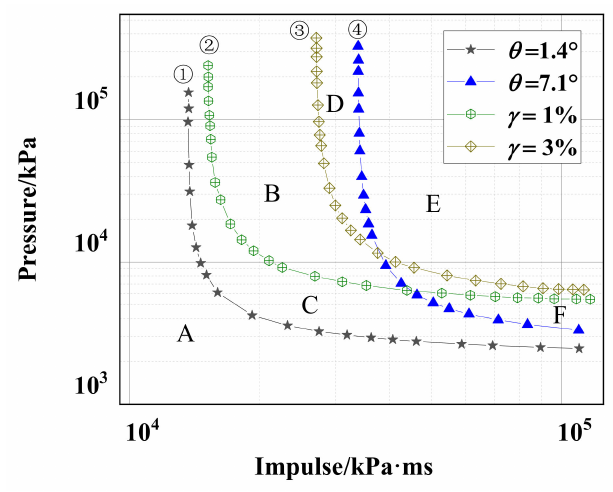
Figure 10. Divisions of bending-shear response P-I